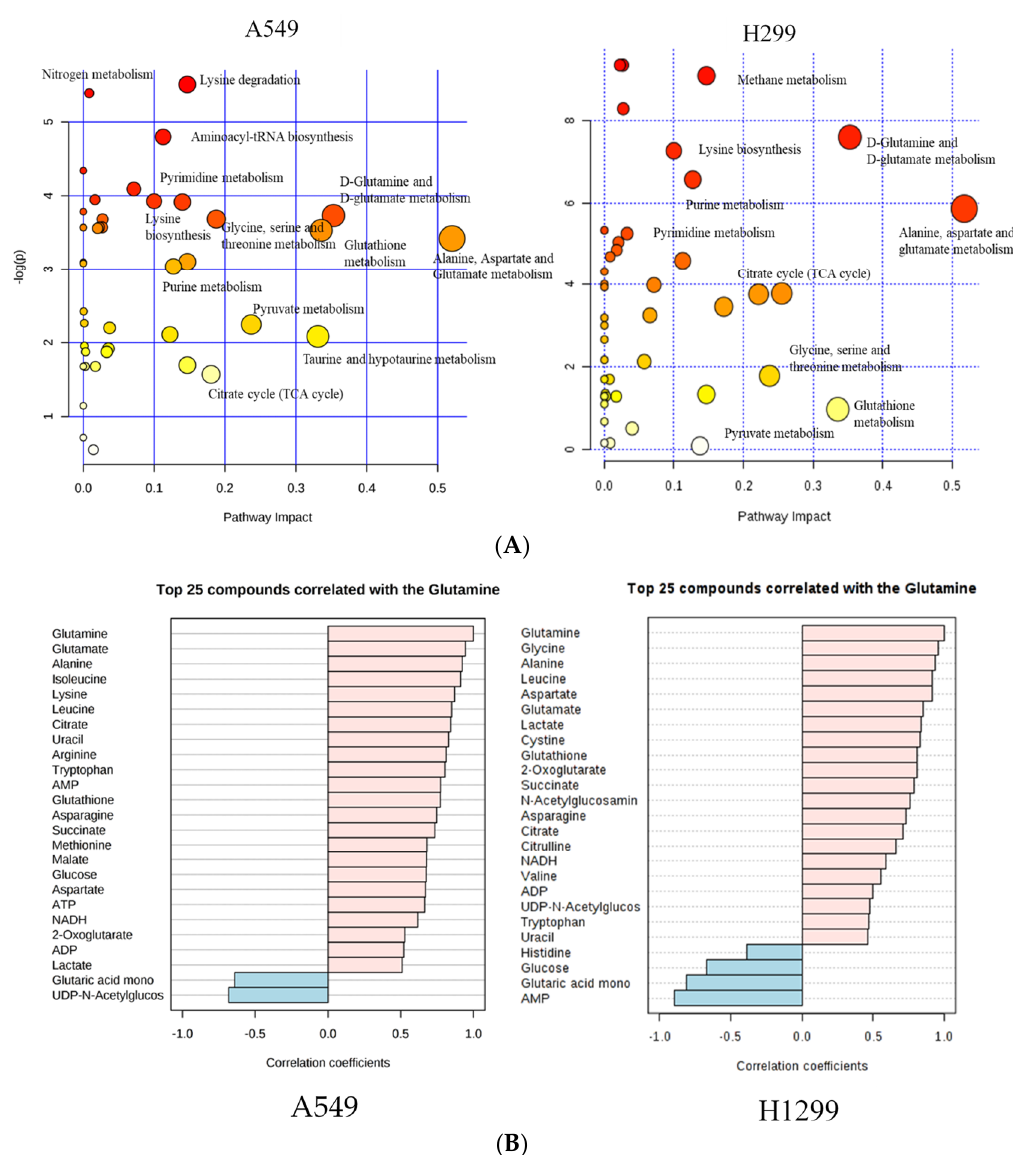
Figure 3. The most predominant altered metabolic pathways ( A ) and top 25 metabolites correlated with glutamine ( B ). Summary of the altered metabolism pathways (A) after treating with/without δT for 72 h, as analyzed using MetaboAnalyst 3.0. The size and color of each circle was based on pathway impact value and p -value, respectively. Circles, larger and higher along the Y axis, show higher impact of pathway on the organism. The top 25 metabolites, correlating with glutamine level (B) after treating with/without δT for 72 h. X-axis shows maximum correlation; pink color shows positive correlation whereas blue shows negative correlation.